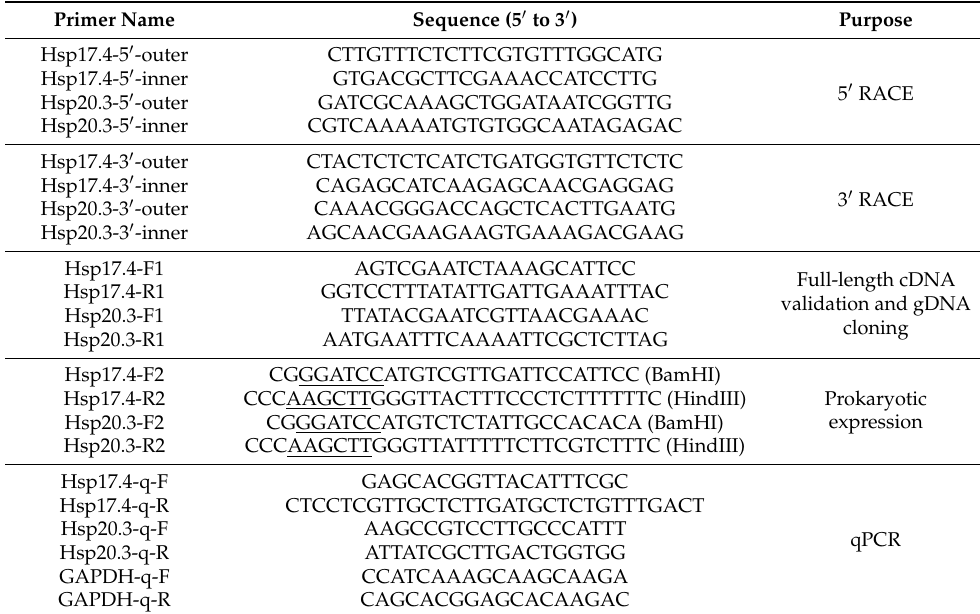
Table 1. Primer sequences used in this